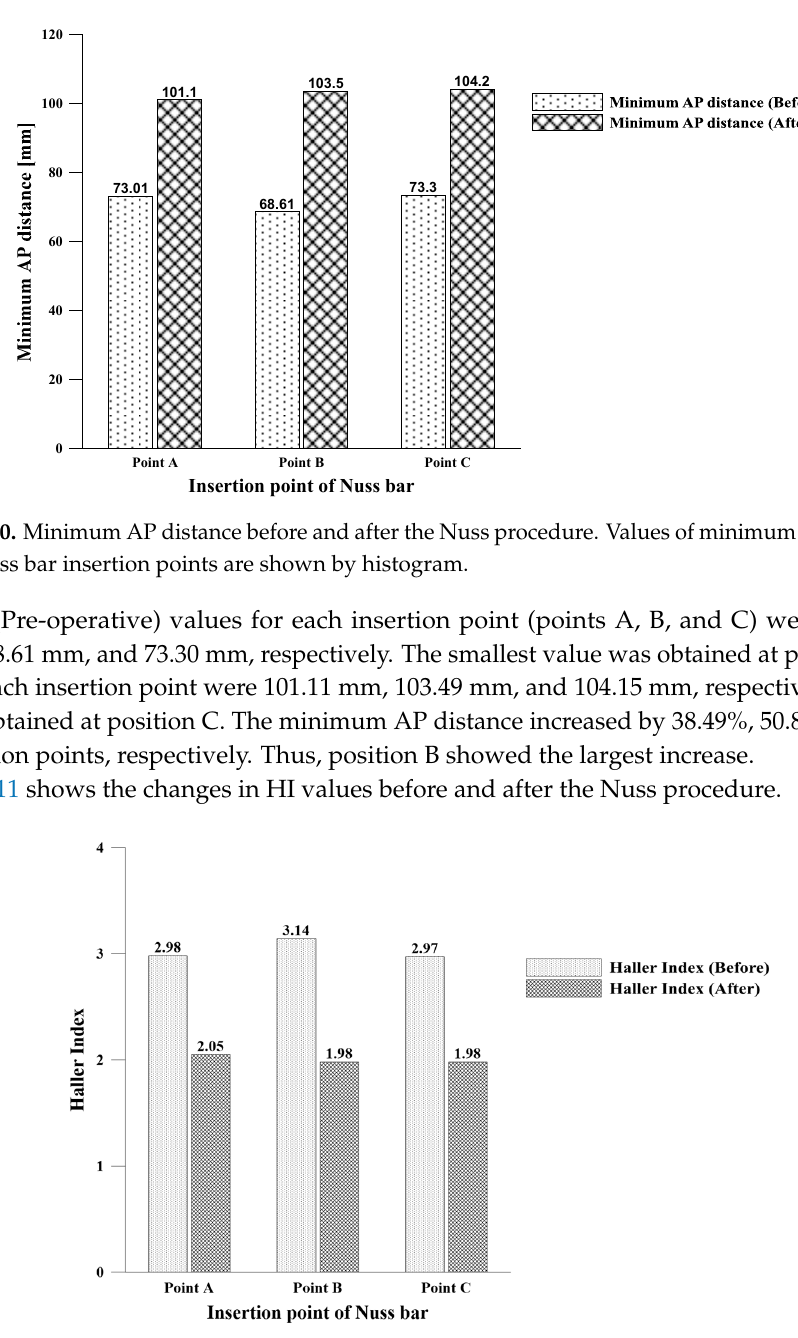
Figure 11. Haller index before and after the Nuss procedure. The values of the Haller index with insertion points of the Nuss bar are shown in the histogram.